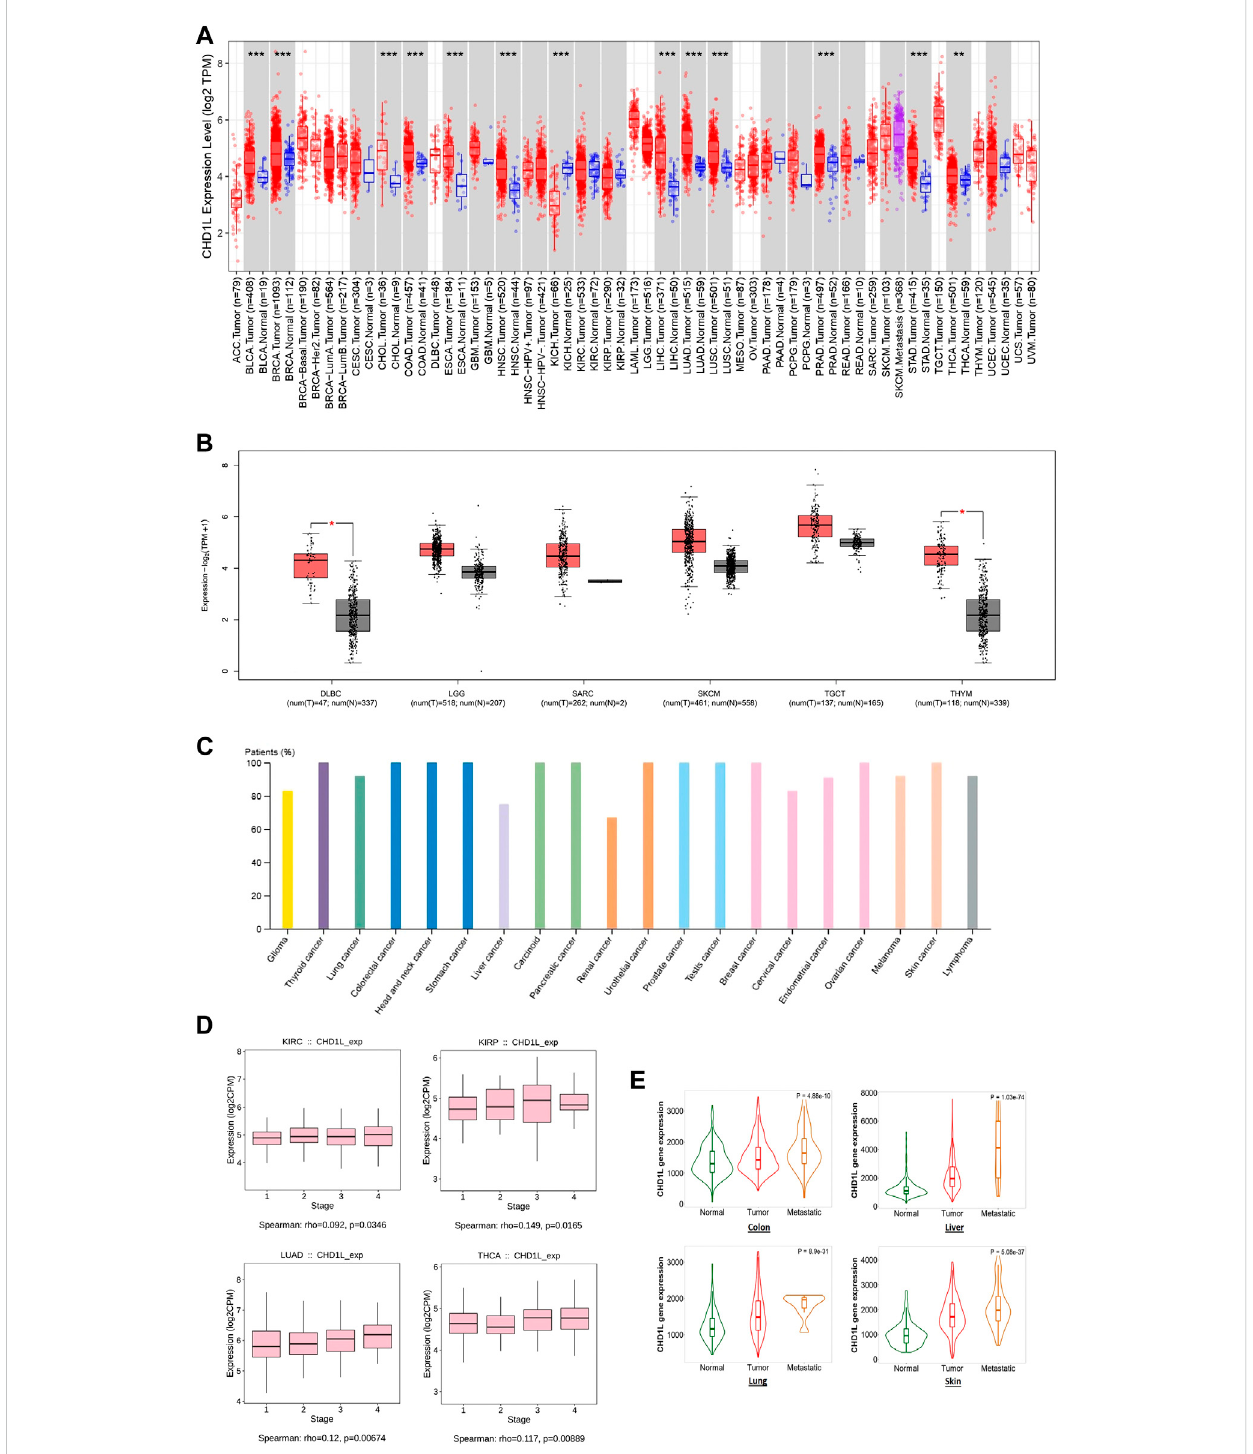
FIGURE 1 CHD1L expression assessment in human cancers. (A) Differential expression of CHD1L in a panel of TCGA tumors analyzed by TIMER2.0. (B) The tumors that lack normal tissue for comparison in TIMER2.0. database and experienced a trend of elevated CHD1L expression in tumor versus normal tissue when analyzed in the GEPIA database. (C) High level of CHD1L expression in several human cancers analyzed on HPA. (D) Tumors experienced a positive correlation between CHD1L expression and the tumor stage when analyzed with the TISDIB webserver. (E) Tumors experienced a consistent positive correlation between CHD1L expression and tissue type